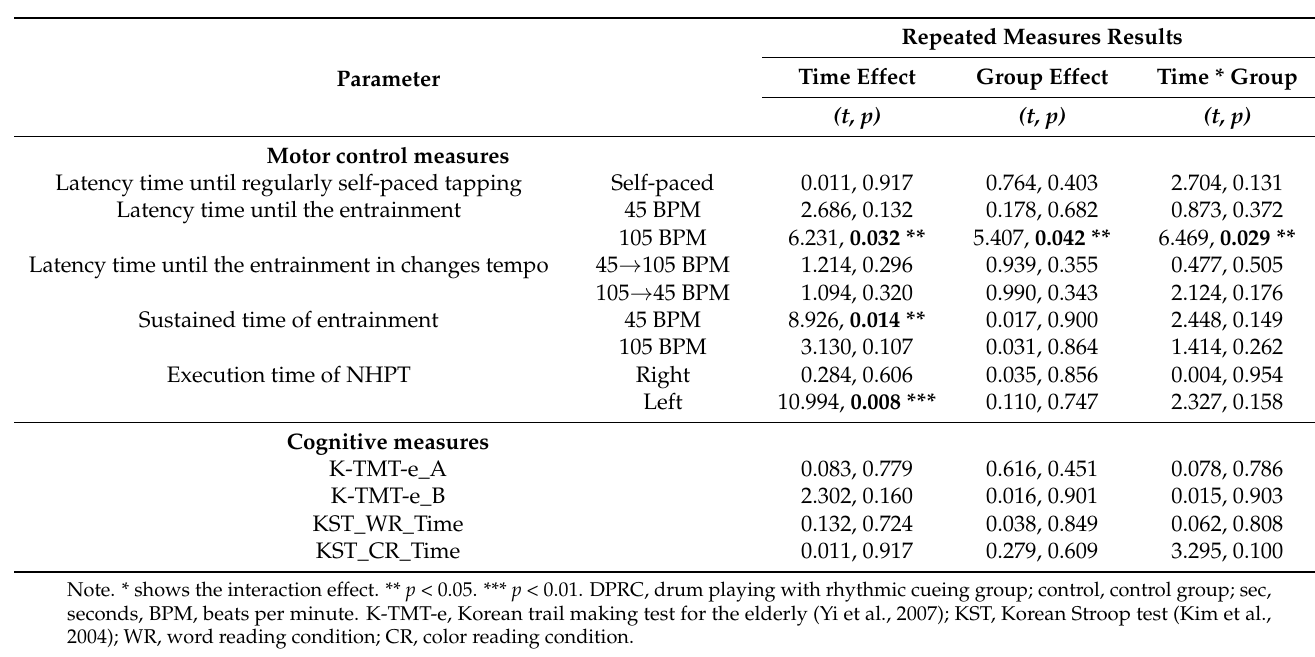
Table 5. The results of a mixed model repeated measures ANOVA.